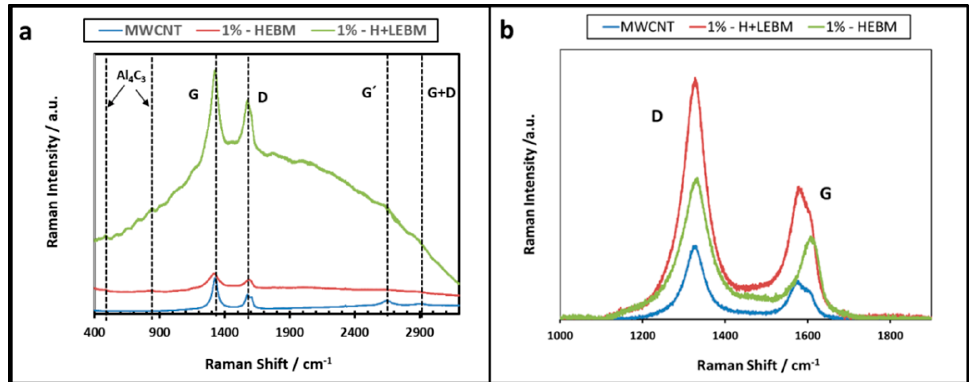
Figure 15. Raman spectra of as-received MWCNTs and the AA7075-1 wt.% MWCNT composite obtained by H + LEBM and HEBM routes. ( a ) Frequency range from 30 to 3500 cm − 1 , 20 scans and exposure time of 15 s; ( b ) frequency range from 1000 to 2000 cm − 1 , 10 scans to 10 and exposure time of 5 s.